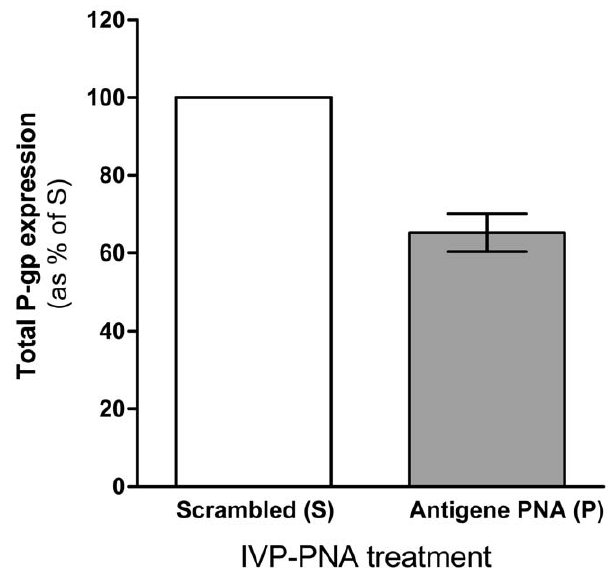
Figure 2. Total P-gp expression in KB-8-5 cells transduced with IVP-scrambled (S) or IVP-antigene PNA (P) was measured by Western blotting using the P-gp specific monoclonal antibody C219; b -actin served as a loading control. The graph represents an average of 4 independent experiments; error bars represent the standard error of the mean. Quantification of P-gp band intensities was performed using ImageJ.